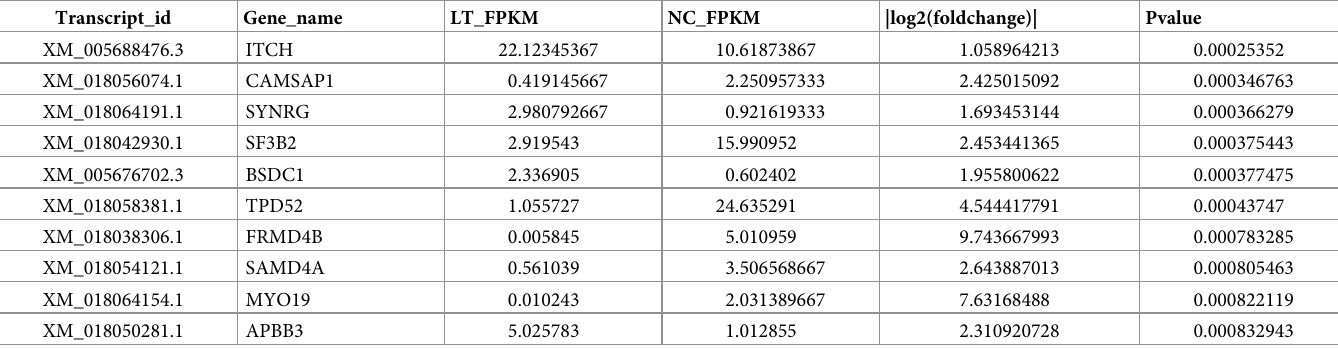
transcriptome and the differentially expressed target gene libraries obtained by miRNA sequencing to find out the overlapping genes of the two libraries. The results of association analysis showed that two out of the 14 miRNAs significantly differentially expressed in the light control group and were closely associated with differential target genes. These two miRNAs were highly expressed in the light group. miR-107 potentially targeted BSDC1, ARSA, rhBDF2 and ADCK5, among which miR-30 potentially targeting ALDH3A2 and MFAP4 (Table 4). Table 2. Differentially expressed genes in the top 10 between light control and normal group (Continued) .